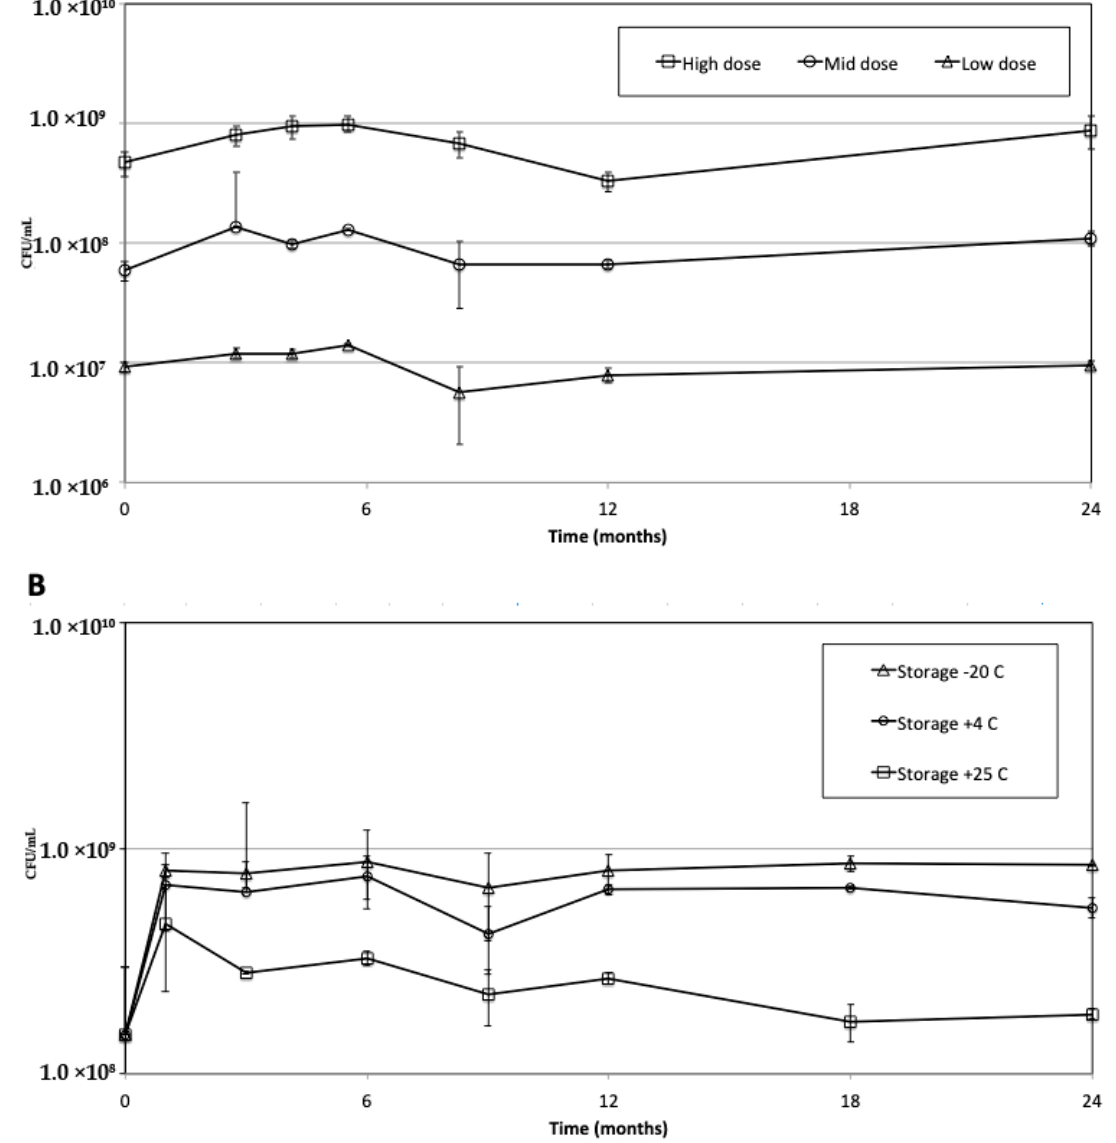
Figure 3. Microbiological stability of the BPZE1 drug products over time. ( A ) The liquid BPZE1 drug product at 10 7 CFU/dose (triangles, low dose), 10 8 CFU/dose (circles, middle dose) and 10 9 CFU/dose (squares, high dose) was stored at − 70 °C for two years, and CFU counts were conducted at the indicated time points. ( B ). Microbiological stability of the lyophilized BPZE1 drug product over time. The lyophilized BPZE1 drug product at 10 9 CFU/dose was stored at − 20 °C ± 10 °C (triangles), 5 °C ± 3 °C (circles) and 22.5 °C ± 2.5 °C (squares) for two years, and CFU counts were conducted at the indicated time points. Vertical lines represent standard deviations. 1.0 × 10 10